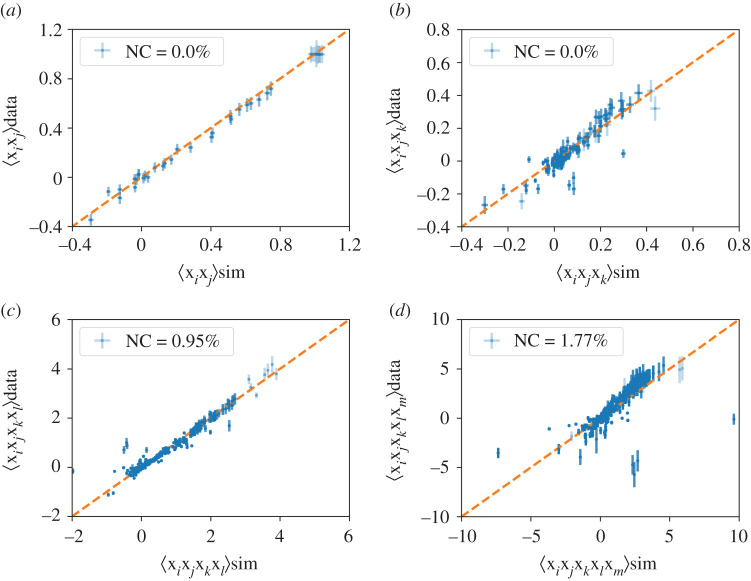
Comparisons between the correlators of order 2 (a), 3 (b), 4 (c) and 5 (d) obtained with the empirical data of year 2012 (y-axis) and the Hamiltonian model (equation (2.3)) (x-axis). We report the percentage of components of each correlation which is not compatible with the data via a t-test with p-value 0.05 (see electronic supplementary material, S6).